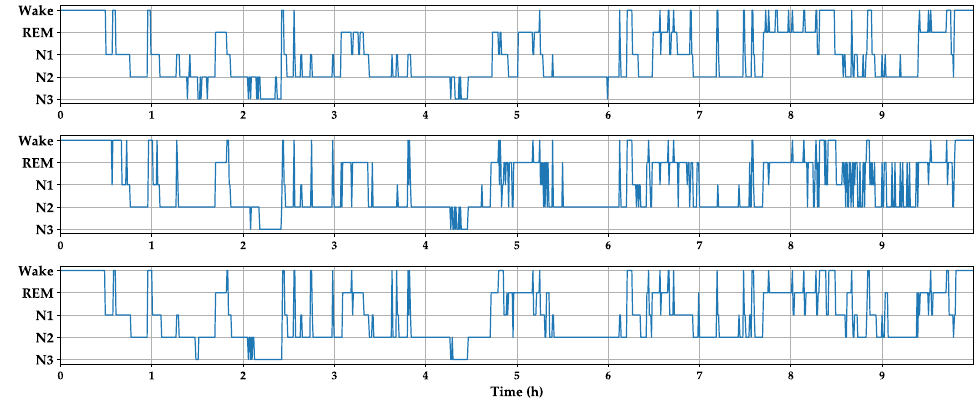
Figure 6. Hypnogram of subject 4 on the first night in the Sleep-EDFx. The graphs from top to bottom are derived from a human expert, baseline model, and baseline model with embedded stage refinement.